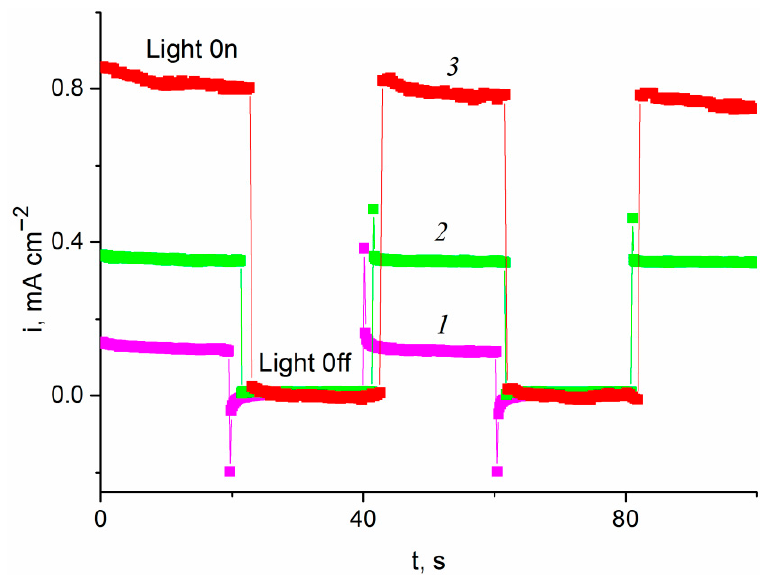
Figure 7. Photocurrent transients obtained at E = 0.4 V on the film photoanode Ti 4+ /Fe 2 O 3 /FTO in dark conditions and under visible light illumination with a power of 100 mW cm − 2 in aqueous solutions: (1) 0.1 M KOH; (2) 0.1 M KOH + 20% CH 3 OH; (3) 0.1 M KOH + 20% C 3 H 5 (OH) 3 .